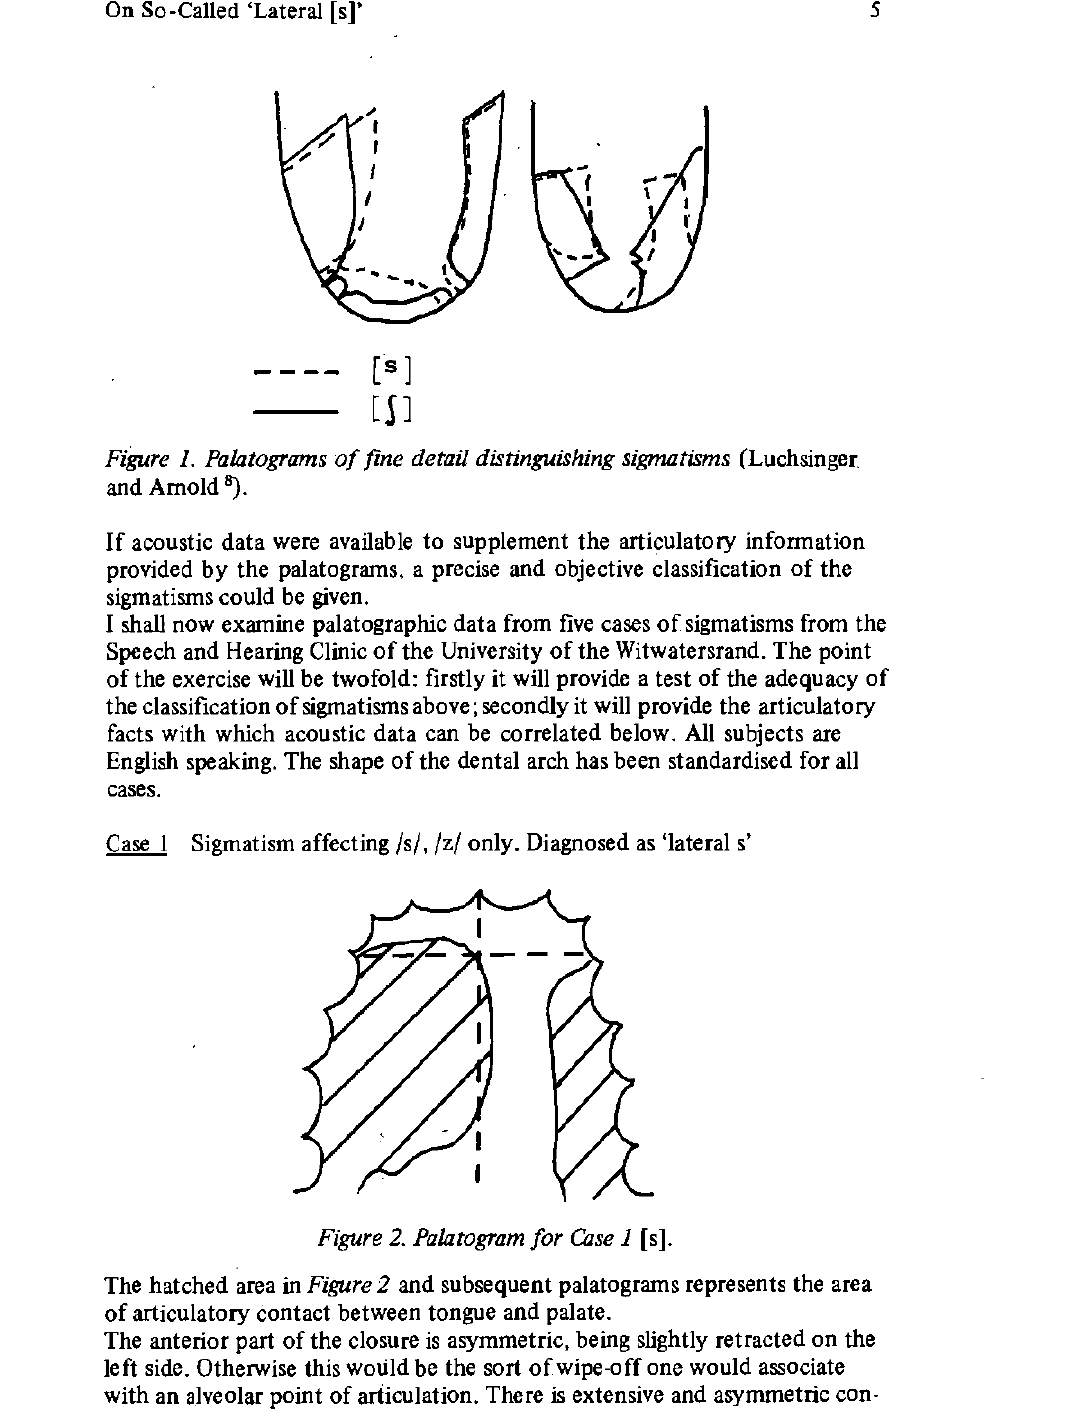
Figure 2. Palatogram for Case 1